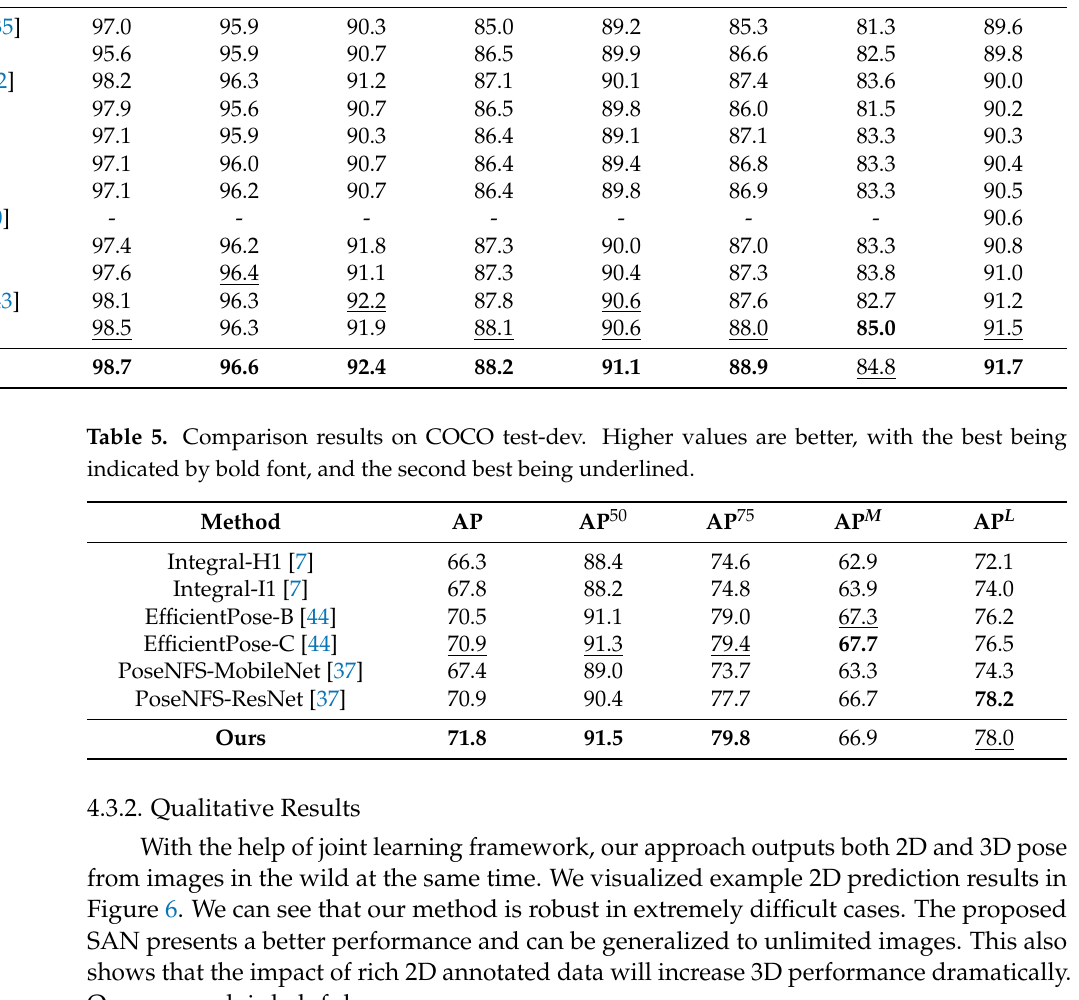
Table 4. Comparison of PCKh@0.5 (%) on MPII. It reports the percentage of detections that fall within a normalized distance of ground truth. Higher values are better, with the best being indicated by bold font, and the second best being underlined. Method Head Elbow SimpleBaseline-152 [35]